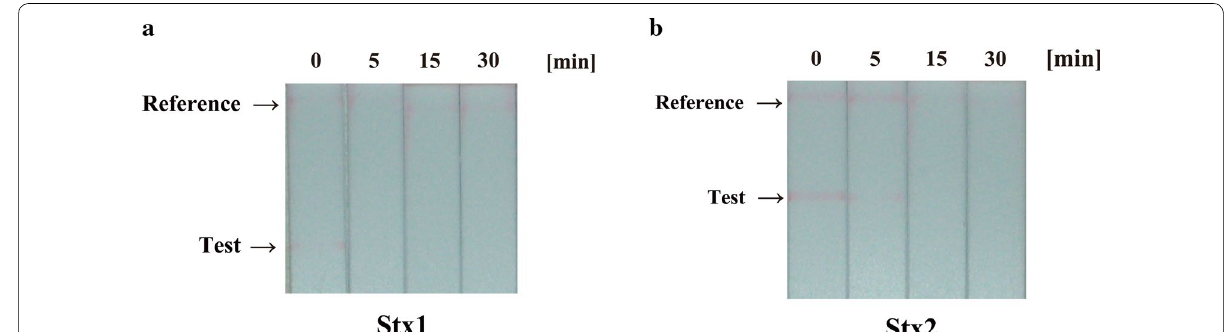
Fig. 1 Immunochromatography of Shiga toxin 1 (Stx1) and Shiga toxin 2 (Stx2) after nitrogen gas plasma treatment. A coverslip containing dried spots from 20 μl aliquots of a 1 μg/ml solution of Shiga toxins (Stx) including Stx1 ( a ) and Stx2 ( b ) was treated with nitrogen gas plasma using a bi-polar and low-pressure plasma-triple effects sterilization (BLP-TES) device (1.5 kpps) for 0, 5, 15, or 30 min. The recovered Stx1 and Stx2 samples were analyzed by immunochromatography using an NH immunochromato VT1/2 kit (NH Foods Ltd., Osaka, Japan). Test lines for Stx1 and Stx2, and reference lines for the internal control are indicated by